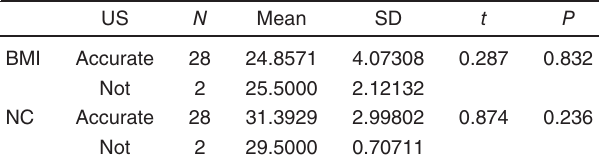
Table 1 Relation between accurate ultrasound and BMI and neck circumference